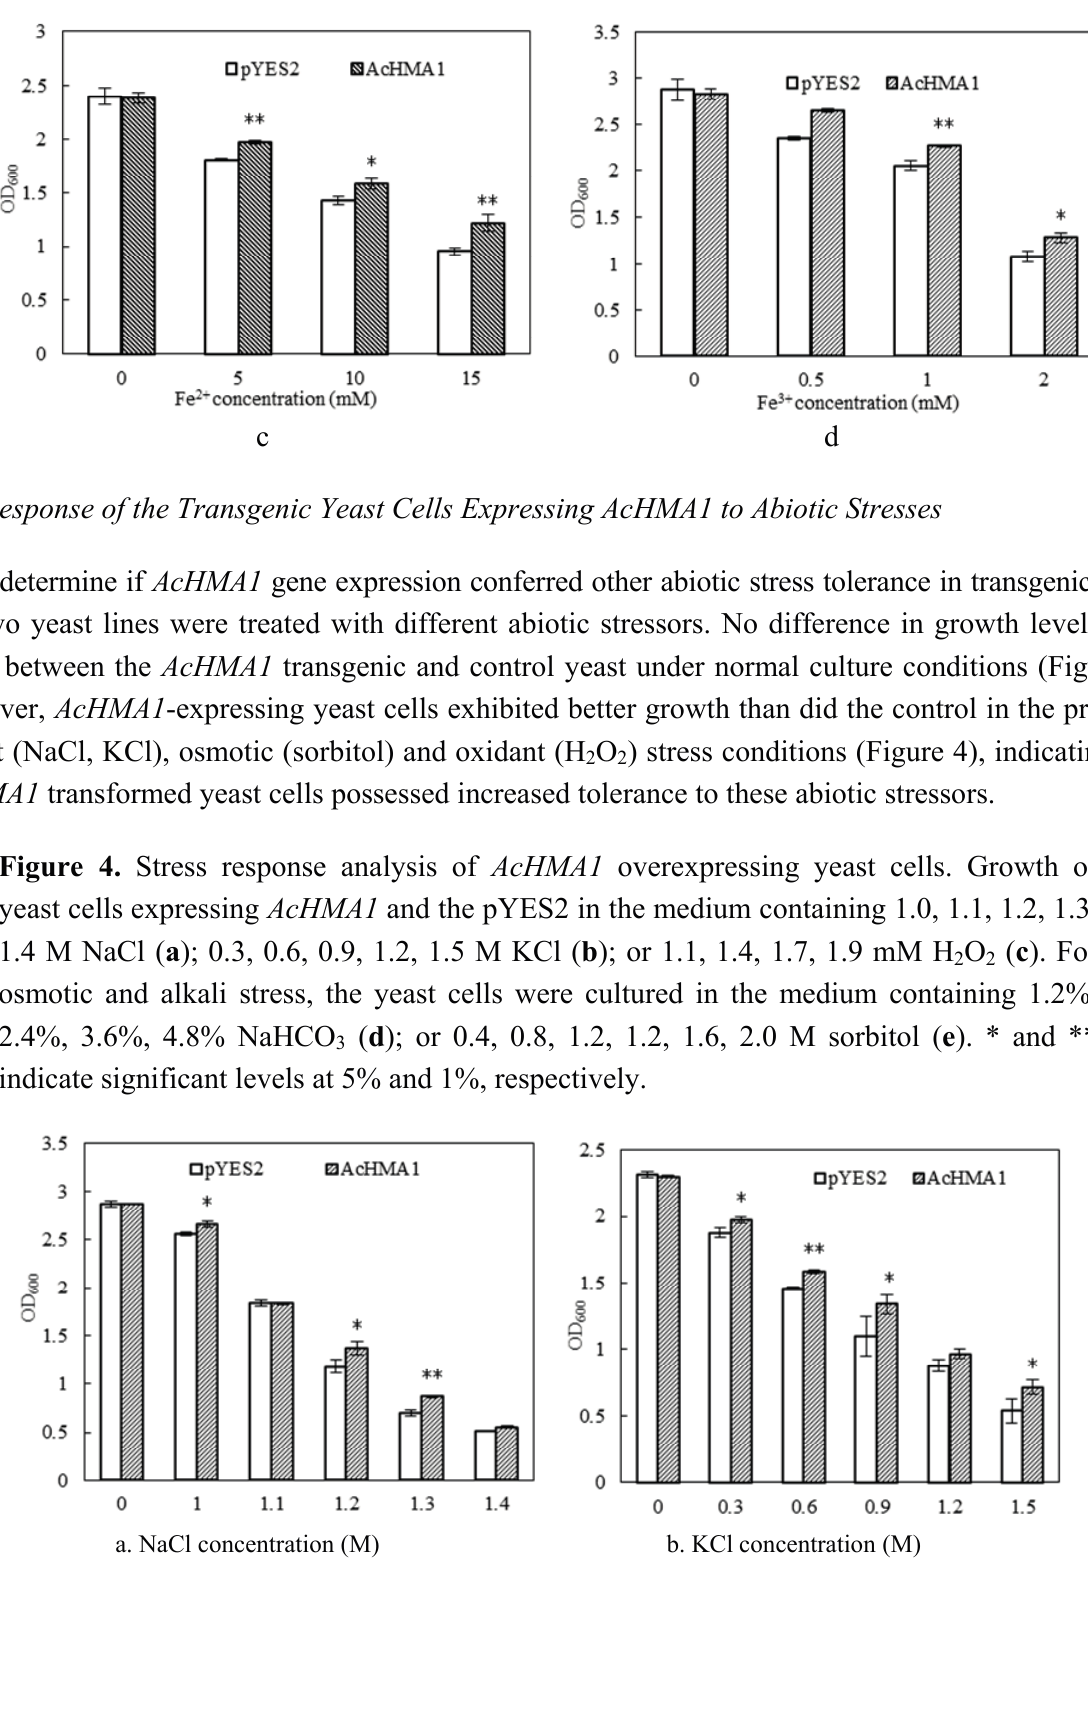
b. KCl concentration (M)a. NaCl concentration